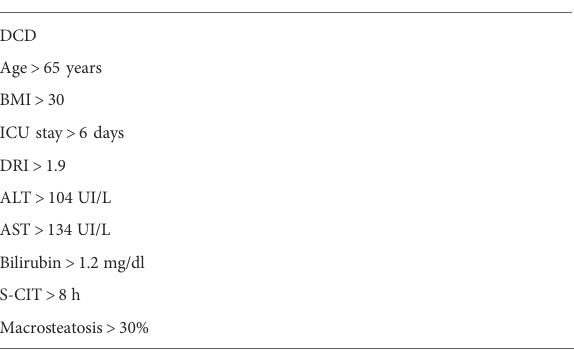
TABLE 5 List of donor parameters: occurrence of two or more of these factorswasconsideredtode fi neamarginaldonorforgraftstreatedbyMP. Donor